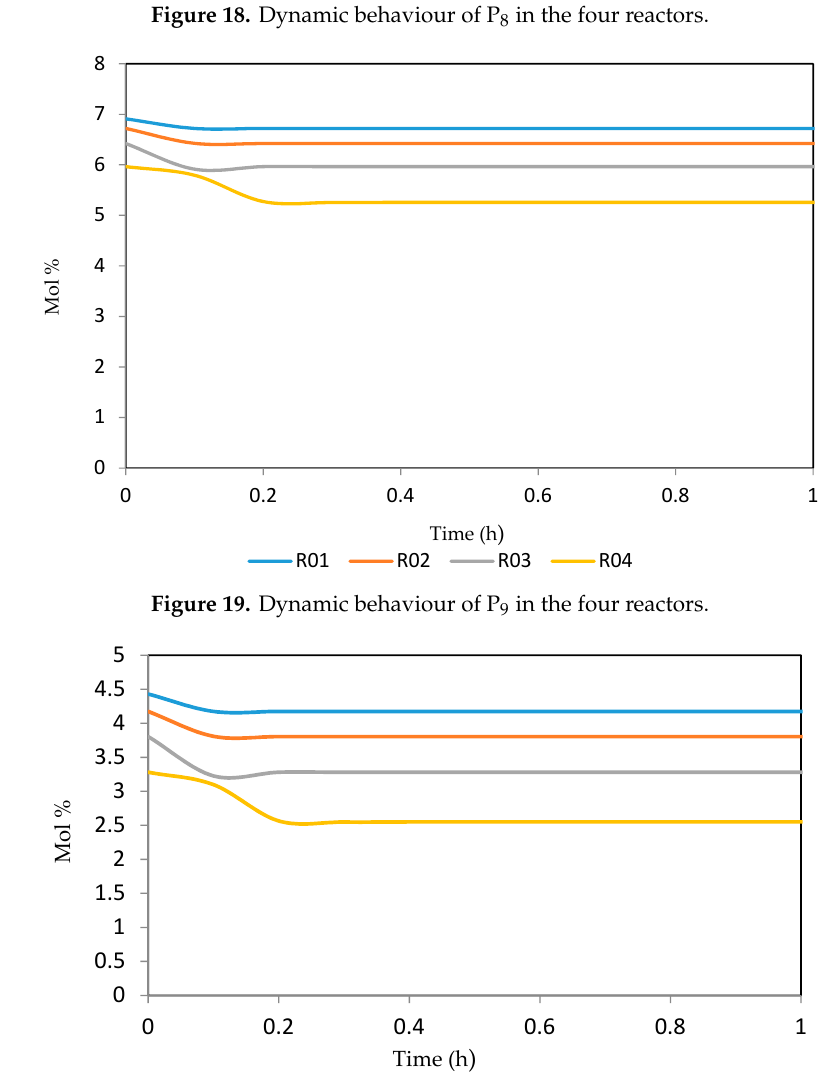
Figure 20. Dynamic behaviour of P 10 in the four reactors.